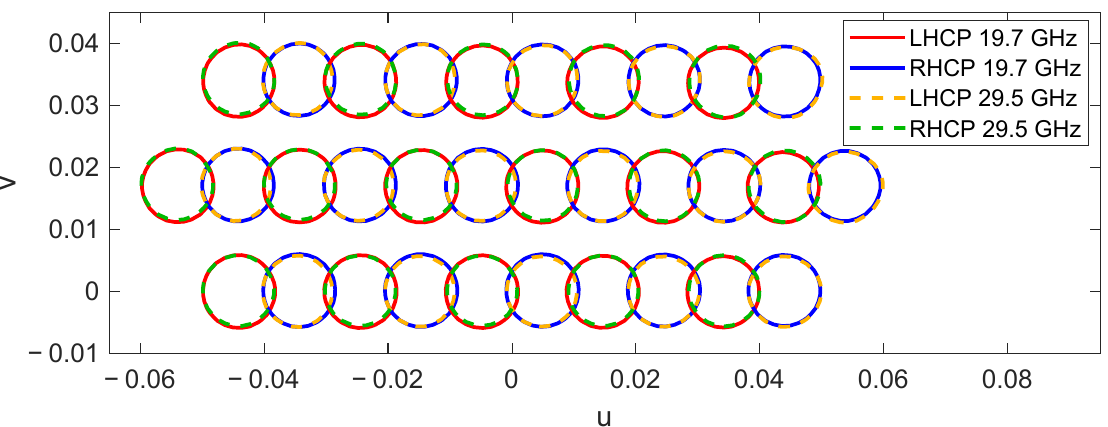
Figure 18. Contours of 32 beams generated simultaneously at 19.7 GHz and 29.5 GHz by the 1.8-m dual-band parabolic reflectarray illuminated by 16 feeds.